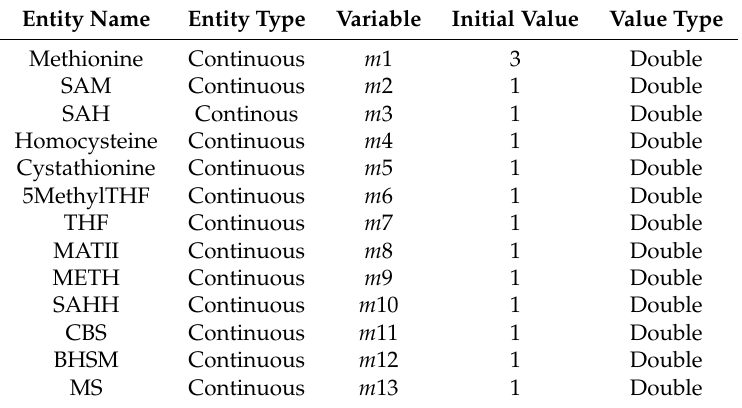
Table 3. Correspondence between biological components and HFPN entities.